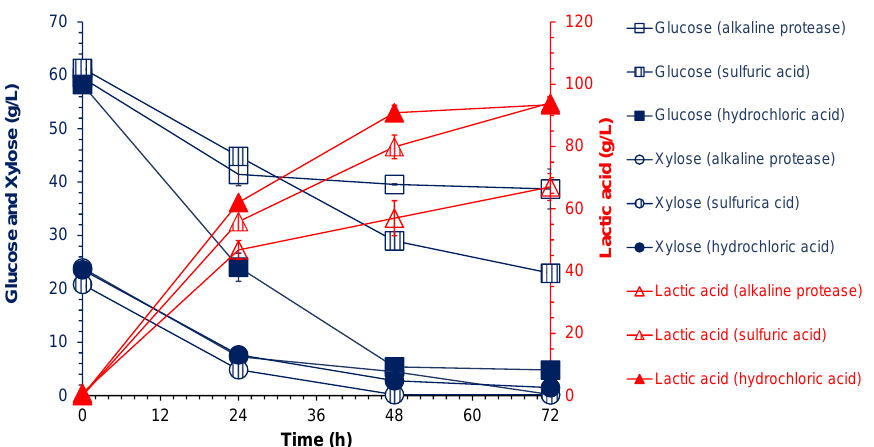
Figure 2. L-lactic acid SSCF using cottonseed meal hydrolysate as the complex nutrient source. The cottonseed meal was hydrolyzed by 3% alkaline protease #2, 5% sulfuric acid, or 5% hydrochloric acid. Conditions: 25% ( w / w )-solids loading: 42 ◦ C, 150 rpm, 72 h. The fermentation pH was controlled